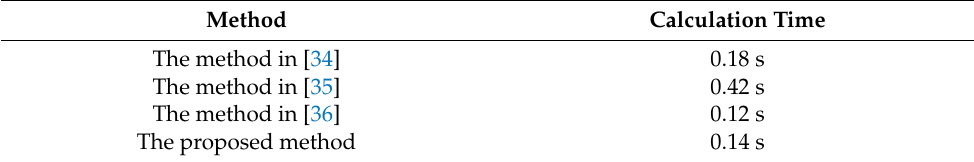
Table 4. Calculation time of different methods.